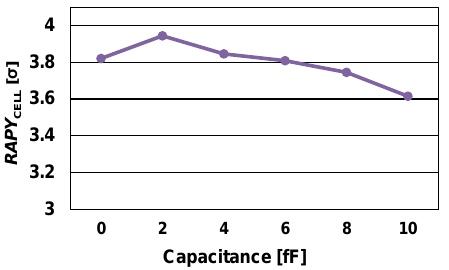
Figure 8. RAPY CELL of TSSC with respect to capacitance value when an additional capacitor is as- sumed. Table 1. Summary of the simulation results in terms of iso-area (identical Tr. size) and iso-power.